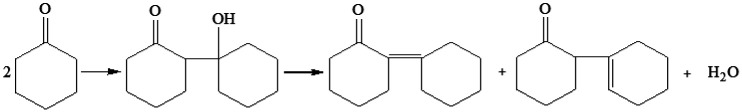
Reaction mechanism of cyclohexanone catalysed by HRF5015.